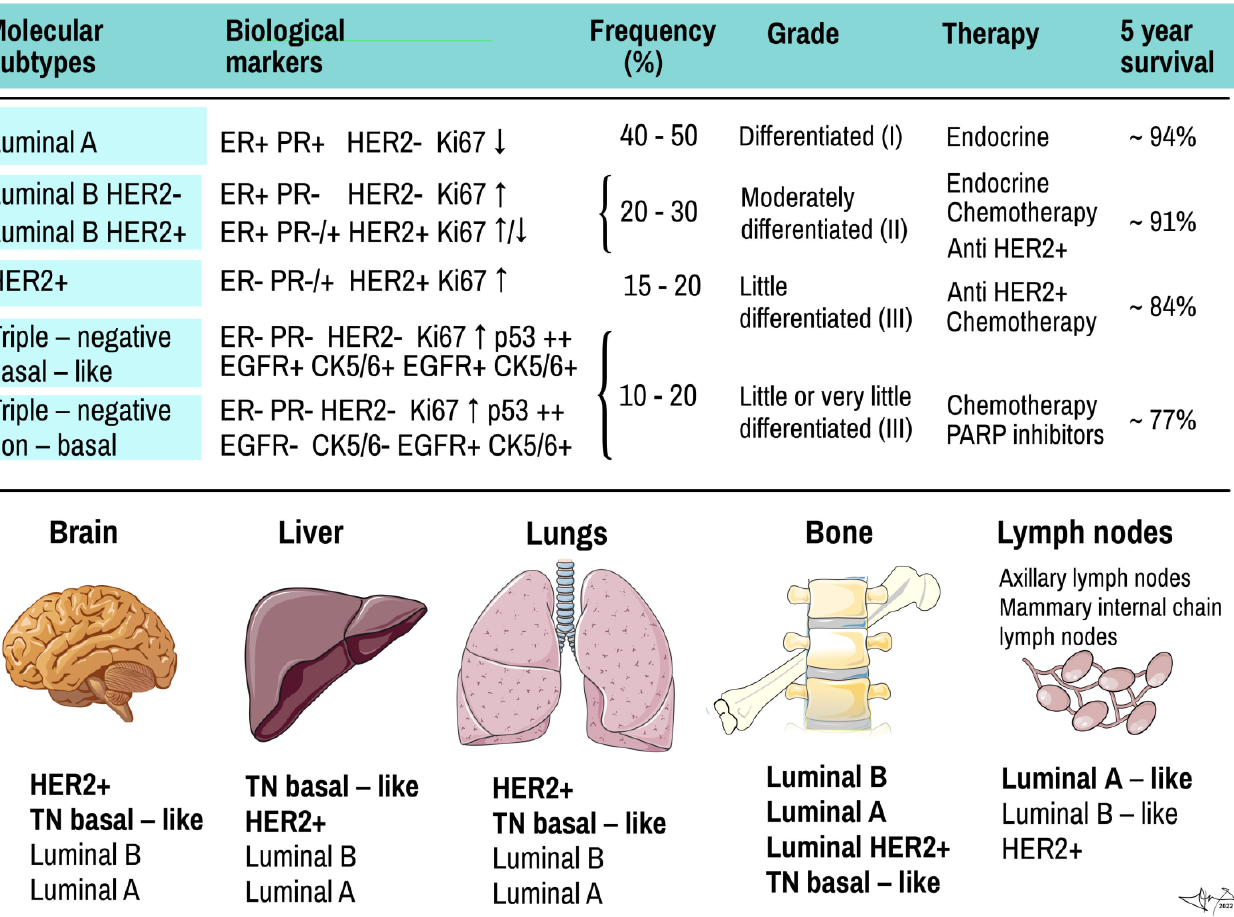
Figure 2. Molecular subtypes of BC and preferred places they metastasize. Upper panel: molecular subtypes of BC. TN, triple negative tumour. ER and PR, oestrogen and progesterone receptor; EGF, epidermal growth factor receptor; HER2+, HER2+/neu/EGF-like growth factor receptor; Ki67, proliferation related antigen; p53, product of TP53 tumour suppressor gene. Lower panel: most common organ and tissue sites of metastases of different types of tumours. Individual types are arranged in the same order as often they metastasize (in bold the rate exceeds 40%). Data combined [6,9,19,20,25,45]. Some picture items credited to Servier Medical Arts (CC-BY-3.0 licence; https://cre-